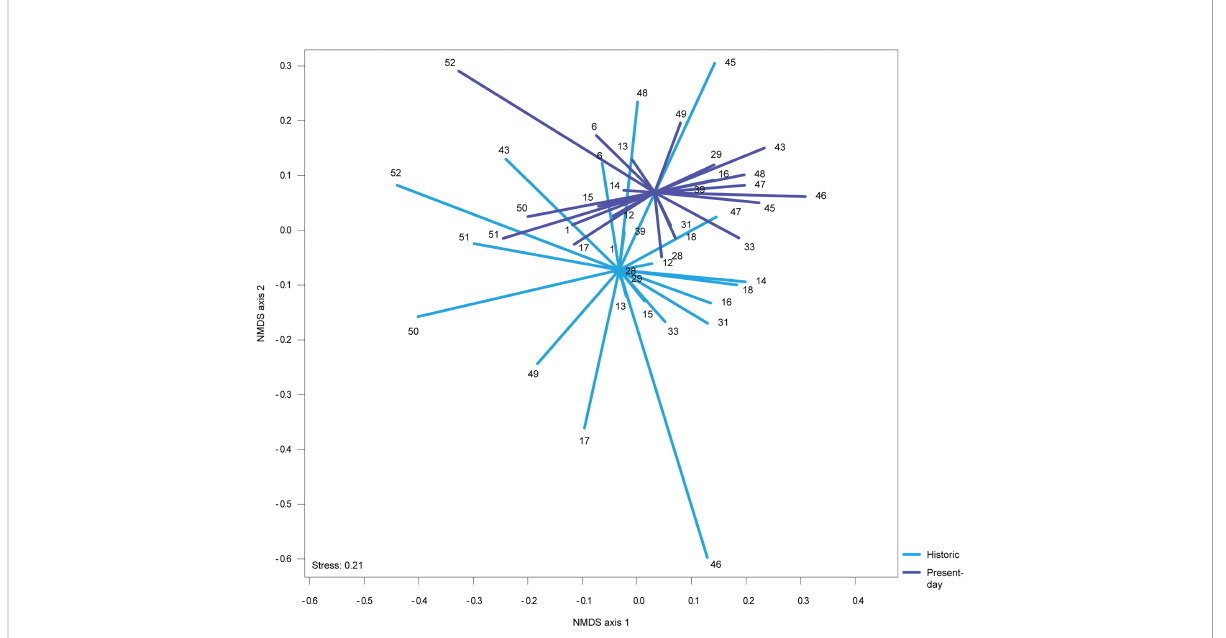
FIGURE 4 NMDS ordination plot based on the Bray-Curtis dissimilarity index for the list of common sites between present-day (2020-2021) and historical (2001-2005) sampling campaigns. Blue lines connect each historic location to its centroid and the purple lines connect each present-day location to its centroid. Locations are depicted by an ID number, for more details see Supplementary Table 2